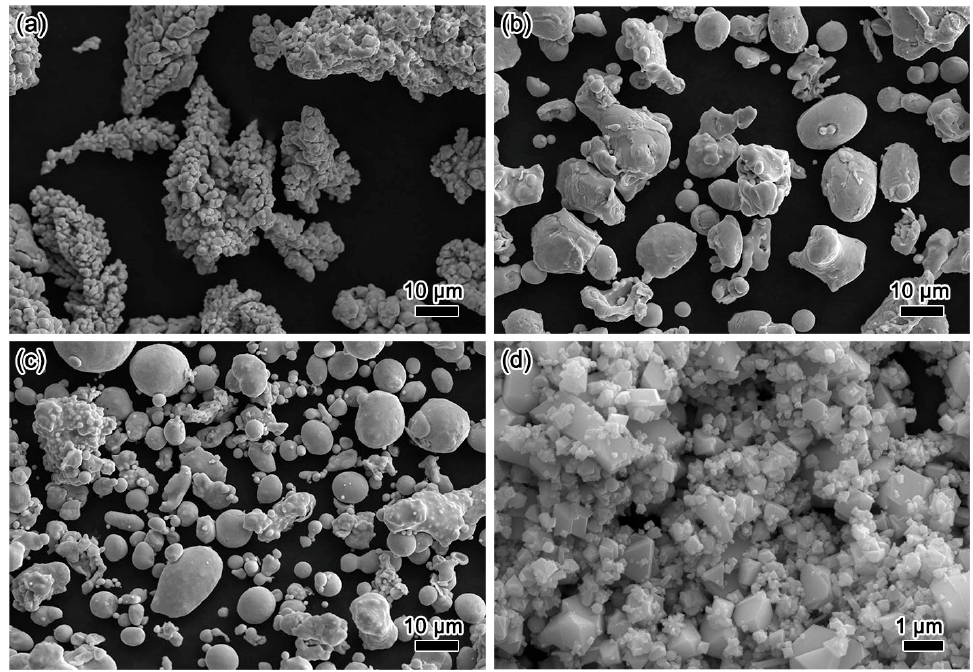
Figure 1. The morphology of electrolytic Cu powder ( a ), atomizing CuZr alloy powder ( b ), atomizing CuLa alloy powder ( c ), and ZnSnO 3 powder ( d ).